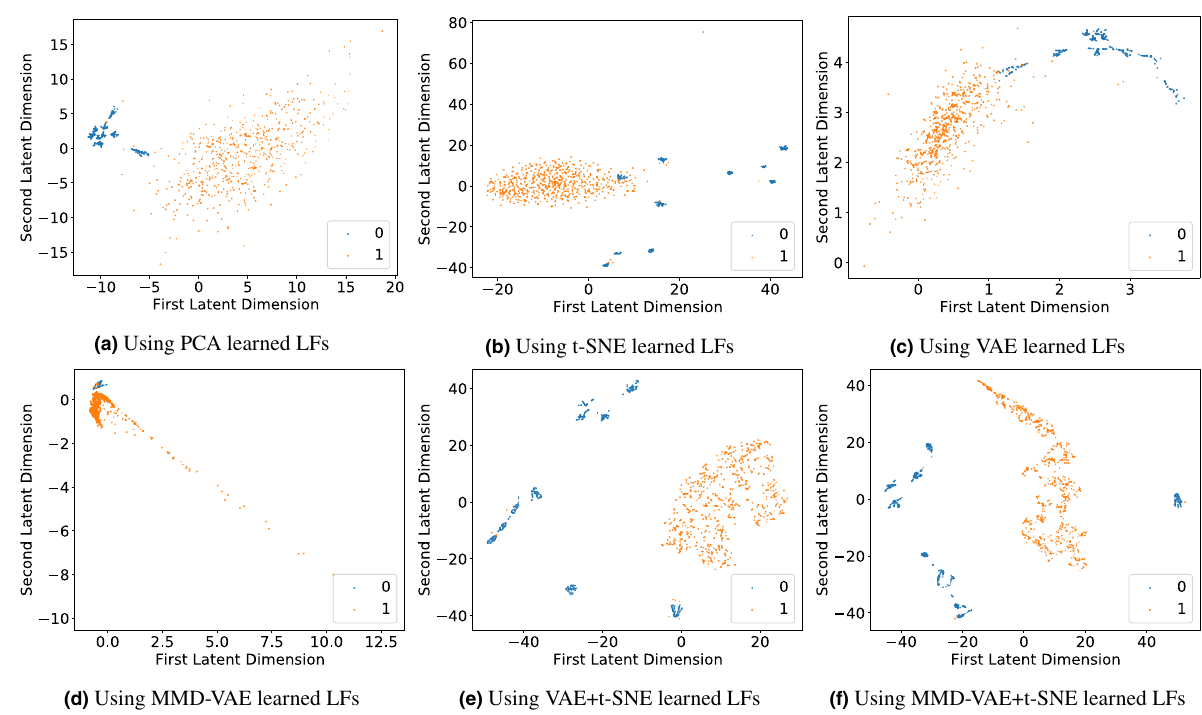
Figure 2. Clustering of normal and cancer samples using the LFs learned using unsupervised PCA, t-SNE, VAE & MMD-VAE (using 2D for PCA & t-SNE and first 2 LFs for VAE and MMD-VAE) ( a )–( d )) on DNA methylation (mono-omics) data from the GDC cohort. t-SNE was used ( e , f ) on the 128 learned LFs to identify 2 LFs for the clustering. Legends: 0—Normal,